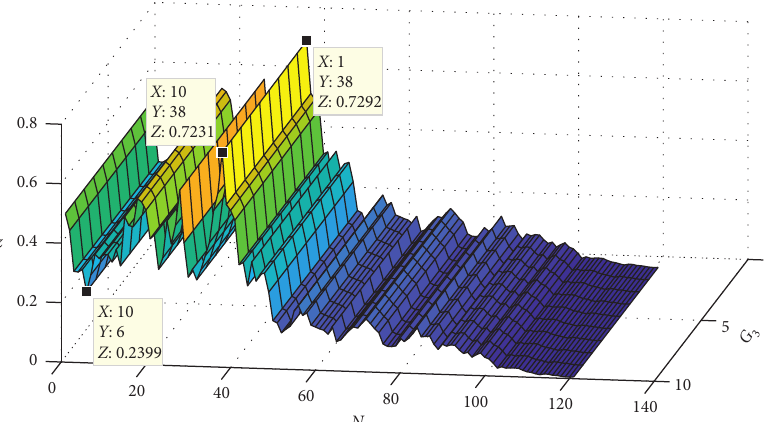
Figure 3: The impact of social benefit ( G